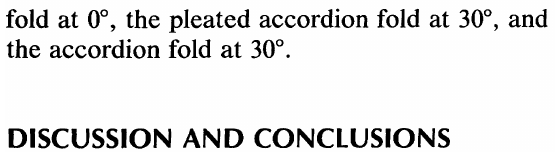
FIGURE 9 The midsagittal view of an occupant in a car with a pleated accordion fold airbag at 0° (case